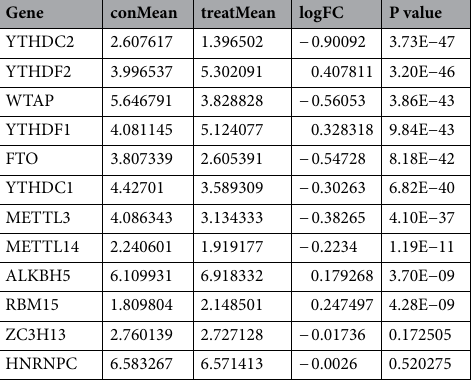
Table 2. Details of the differentially expressed m6A-related